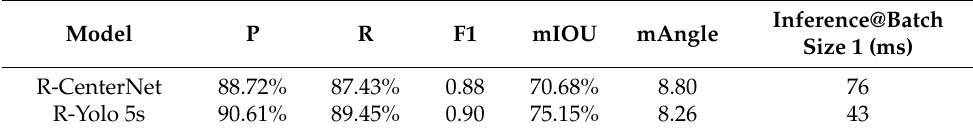
Table 2. Comparison of rotating object detection